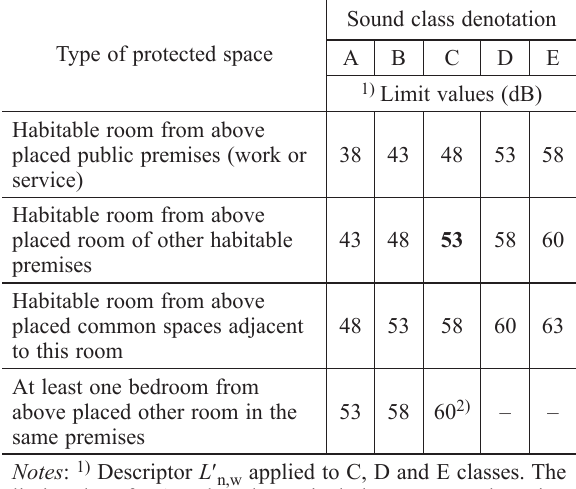
Table 5. The requirements of airborne sound insulation established for vertical (walls) and horizontal (floors) partitions between adjacent premises in dwellings, as the lowest limit values of each sound class (STR 2.01.07:2003)